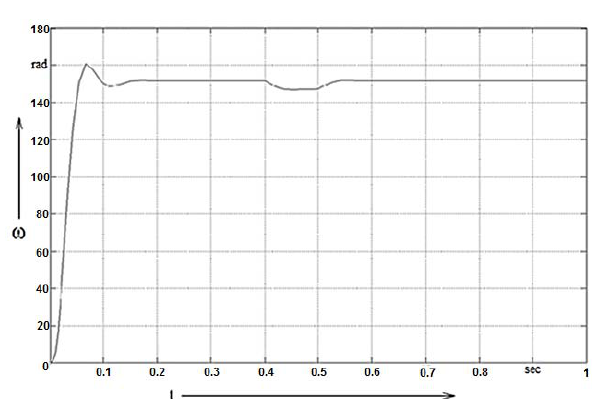
Figure 2. Motor current transient process